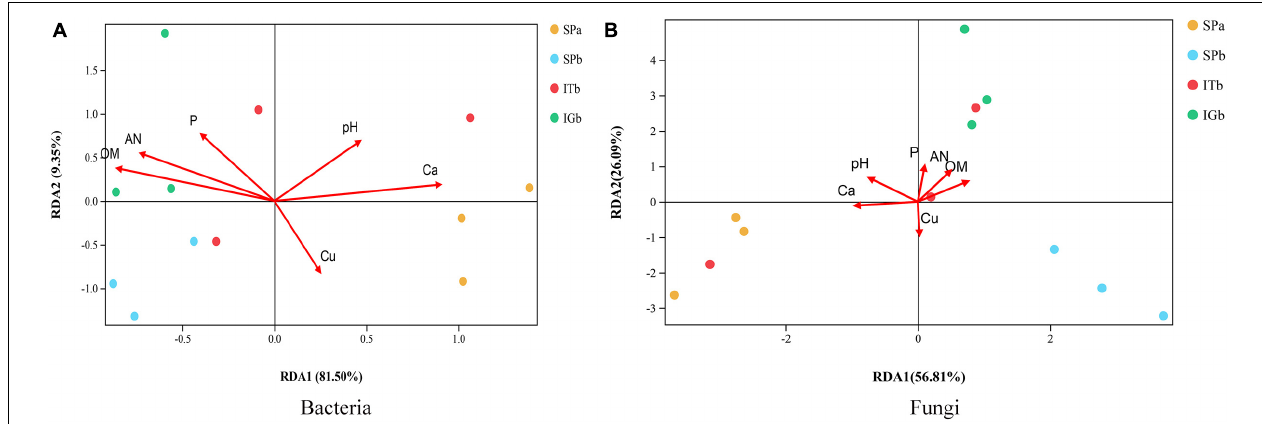
FIGURE 7 | Correlation analysis between the rhizosphere bacteria and fungi, and the soil physical and chemical properties when the soil was used to grow patchouli. (A) Redundancy analysis (RDA) between the soil and the bacterial community. (B) RDA between the soil and the fungal community.